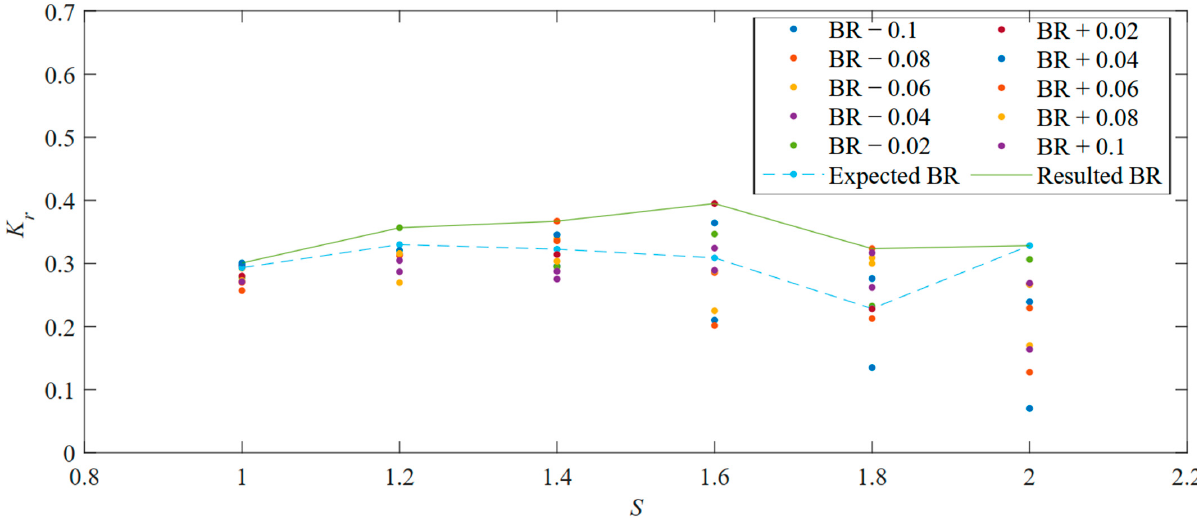
Table 2. Data sampling of the expected BR and ± 1 in 2S/L.